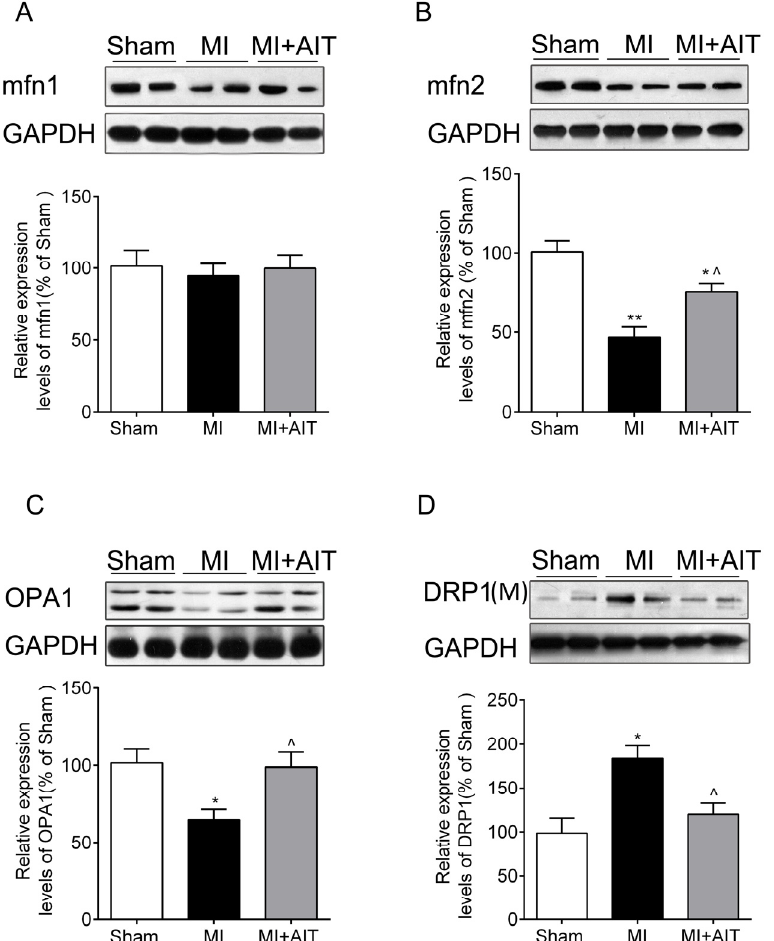
Figure 5. Effects of MI and AIT on mitochondrial dynamic proteins. After 8 weeks, the rats were killed, and the expression levels of mitochondrial proteins mfn1, mfn2, OPA1, and DRP1 were determined by Western blot. ( A ) mfn1; ( B ) mfn2; ( C ) OPA1; ( D ) DRP1. (Top: Western blot images; bottom: statistical results). The significance was calculated using one-way ANOVA followed by Tukey’s post-hoc test. The data are presented as the means ± SEM ( n = 8). * p < 0.05 and ** p < 0.01 vs. sham group; ^ p < 0.05 vs. MI group; M: mitochondria; Sham: sham operation; MI: myocardial infarction; MI + AIT: myocardial infarcted rats subjected to aerobic interval